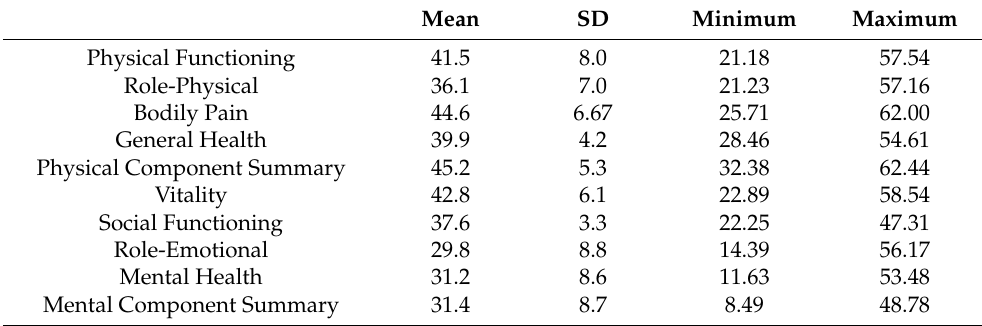
Table 4. Overall summary of HRQoL of the patients according to the subdomains of Physical Component Summary (PCS) and Mental Component Summary (MCS) and their subscales.